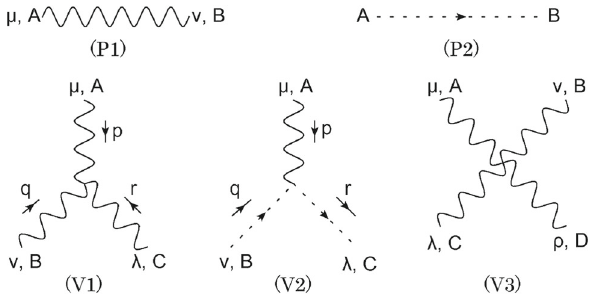
Fig. 1 Feynman rules for the massive Yang–Mills model in the covari- ant